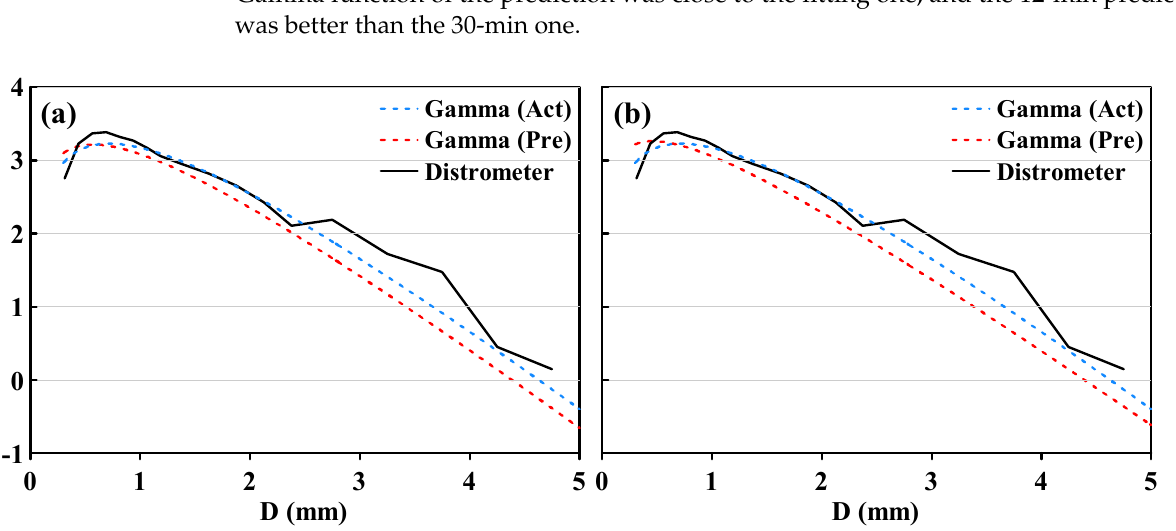
Figure 17. The DSDs of measurement (black solid line), Gamma fitting (blue dotted line), and model prediction (red dotted line, ( a ) 12-min and ( b ) 30-min prediction) at the 86th min of this convective cloud precipitation case.